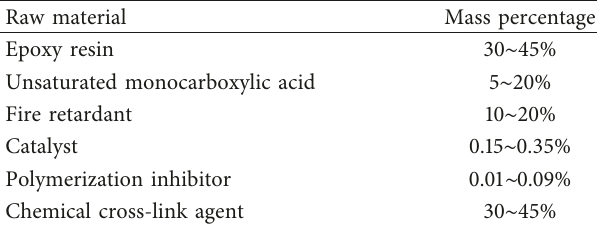
Table 1: Formula design of epoxy resins.